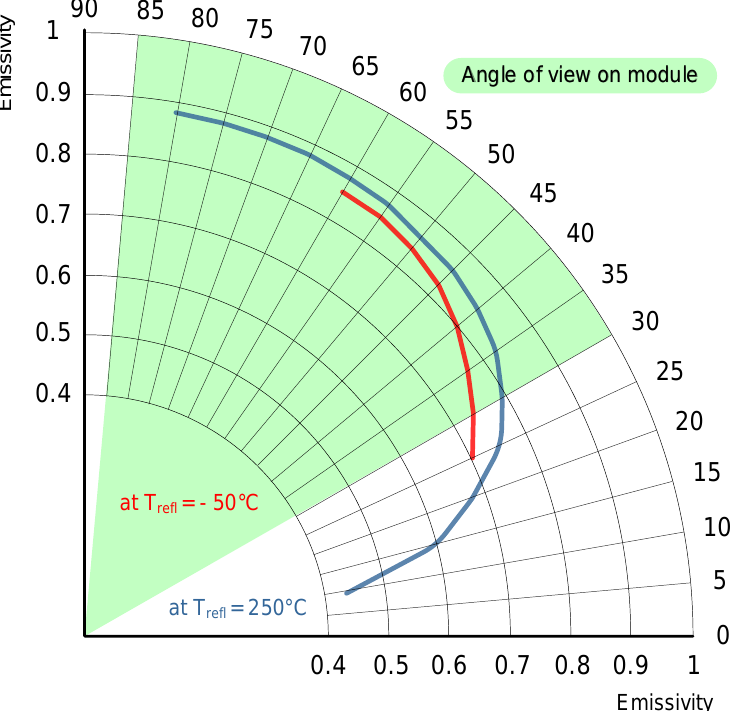
Figure 12. Dependence of module emissivity on the shooting angle. The work in [21] states that emissivity should be selected as 0.85 for glass and 0.95 for a polymer backsheet, if the view angle is within 90–60 ◦ (glass) and 90–45 ◦ (polymer). FLIR’s recommendation is visible in the form of the green space in Figure 12. Information on emissivity changes is especially important when conducting an analysis of a larger area composed of several different thermographic records is necessary because, sometimes, this is the only way we can get complete information about the temperature distribution of the surface of a PV module. Table 5 provides information on the temperature distribution on the module shown in Figure